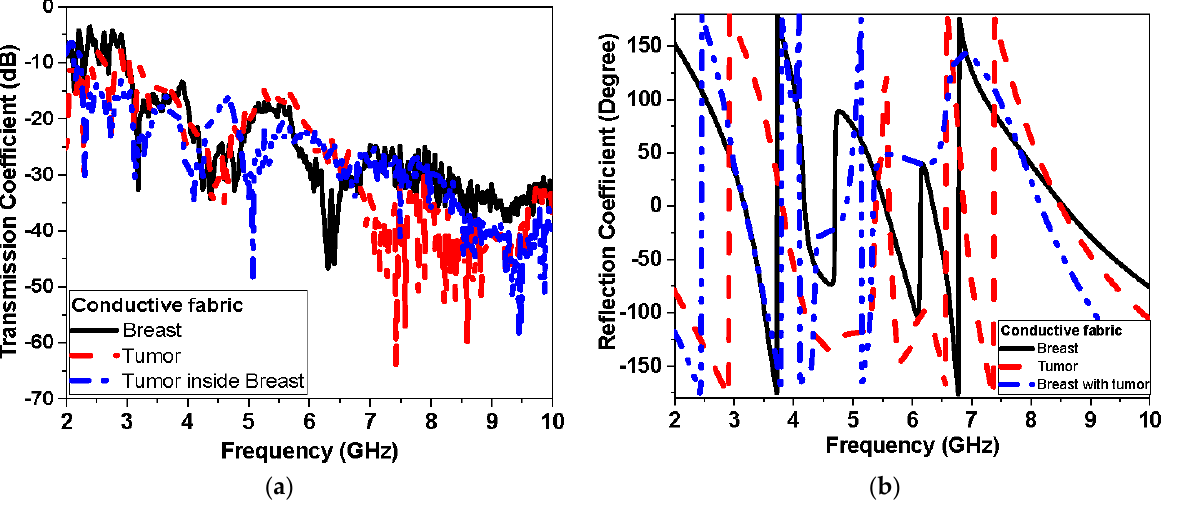
Figure 20. Measured S21 of conductive fabric antenna performance with breast phantom and tumor: ( a ) magnitude and ( b ) phase.